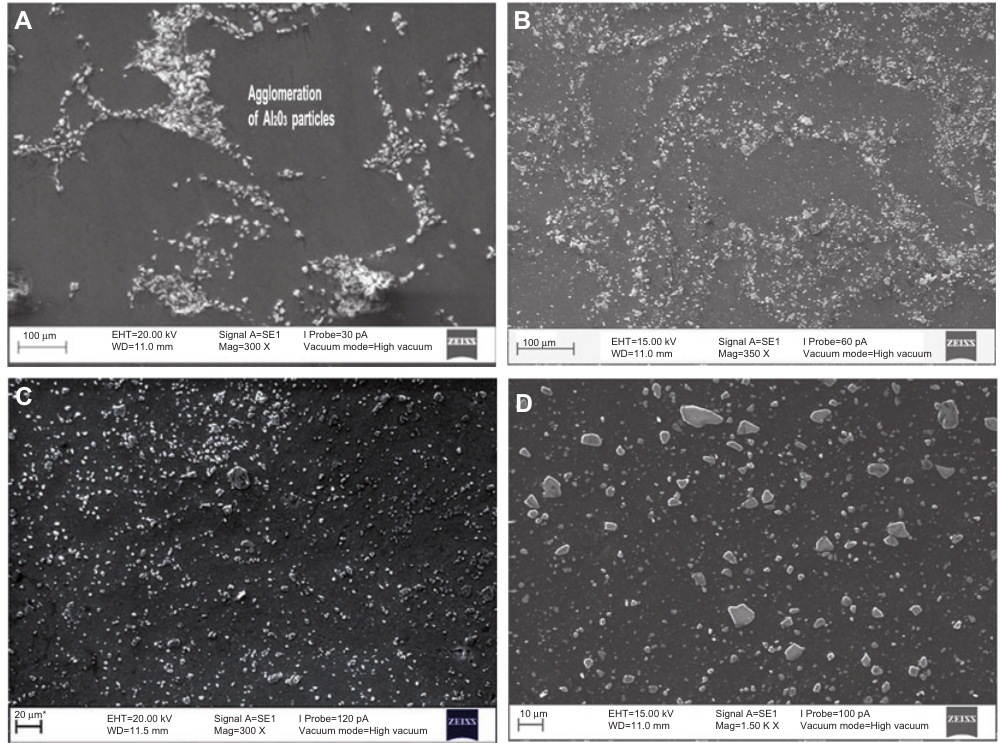
Figure 10 Distribution of Al (D) 7